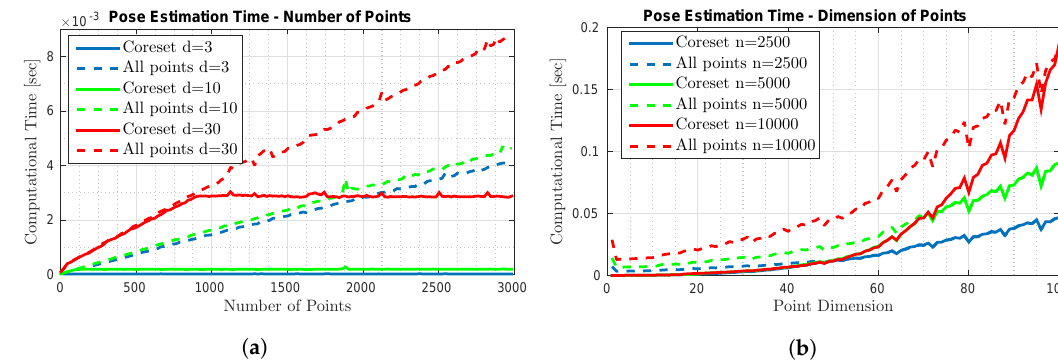
Figure 5. Time comparison between calculating the orientation of n points of dimension d given a previously calculated coreset versus using all n